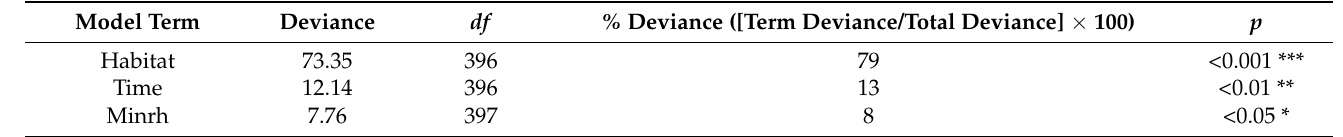
Table 2. Model effects for explanatory variables predicting the presence/absence of Arion hortensis and Arion ater aggre- gates, and Cornu aspersum (taxa harboring medium and high prevalence of Angiostrongylus vasorum from the literature) from quadrats along line transects across 7 study sites in Brighton and Hove and surrounding areas, England, UK. Habitat = habitat type (hardstanding, amenity grassland, natural grassland, woodland/scrub); Minrh = minimum relative humidity (%); Time = time of day (morning, midday, evening). Total deviance = the difference between null (457.13 on 404 df ) and residual (365.54 on 397 df ) deviance for model overall = 92. * < 0.05; ** < 0.01; *** < 0.001.